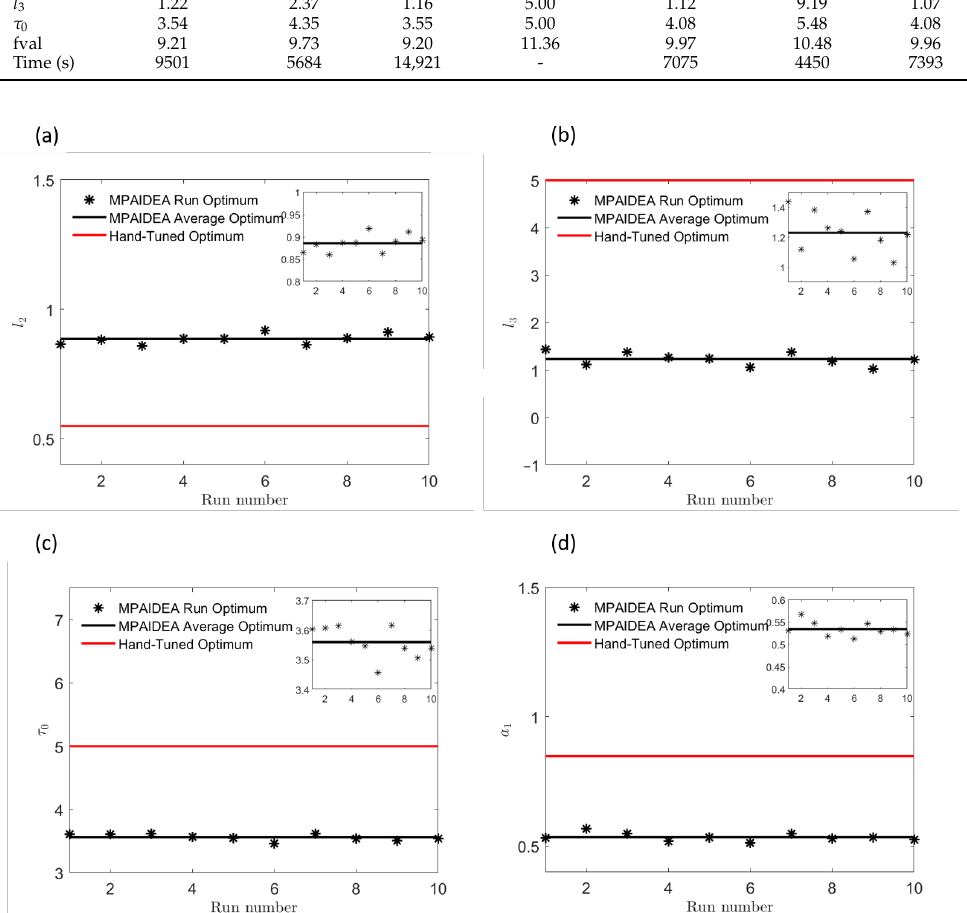
Figure 6. Parameter variance across 10 runs of MP-AIDEA ( a ) l 2 ( b ) l 3 ( c ) τ 0 ( d ) a 1